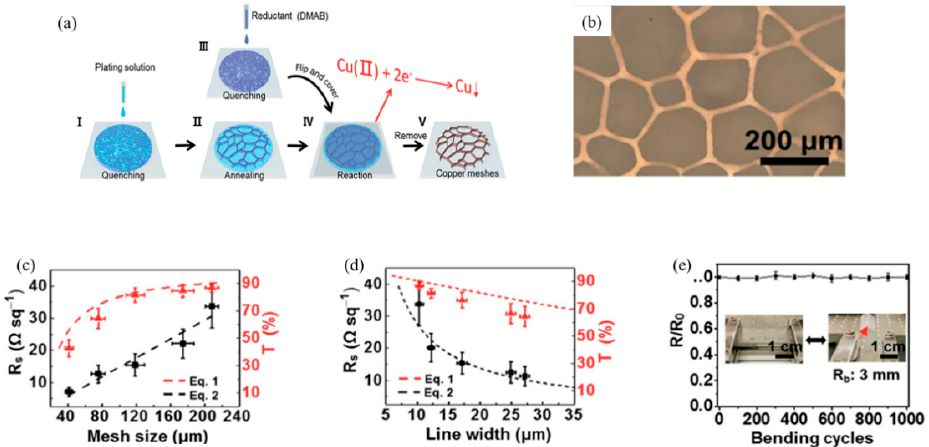
Figure 3. ( a ) Schematic illustration of the preparation of transparent and conductive Ag mesh films; ( b , d ) SEM images of Ag mesh films fabricated with Ag nanoparticle ink after a sintering process; ( c , e ) SEM images of Ag mesh films fabricated with Ag nanoparticle ink after a coupling process [68].